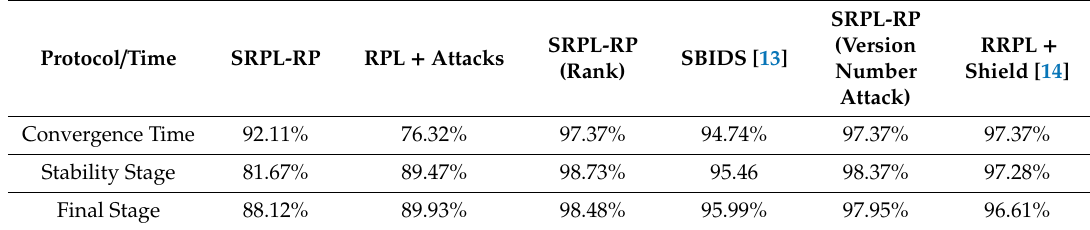
Table 5. Packet Delivery Ratio Comparison in Random Topology.